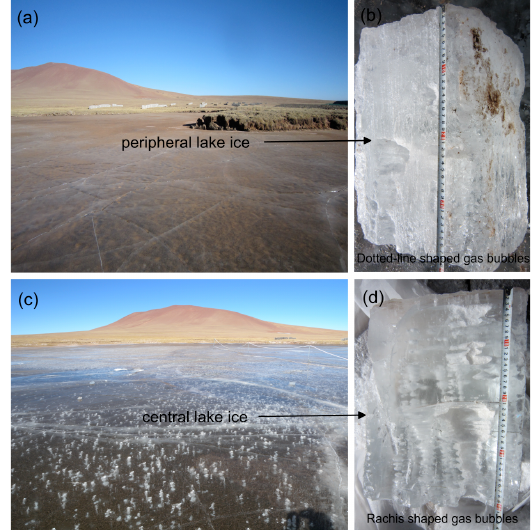
Figure 4. Samples of ice types encountered on the thermokarst lakse of Beiluhe Basin: (a) and (b) show that the dotted-line shaped gas bubbles distribute in the peripheral lake ice cover; (c) and (d) show the rachis-shaped gas bubbles distribute in the central lake ice cover.